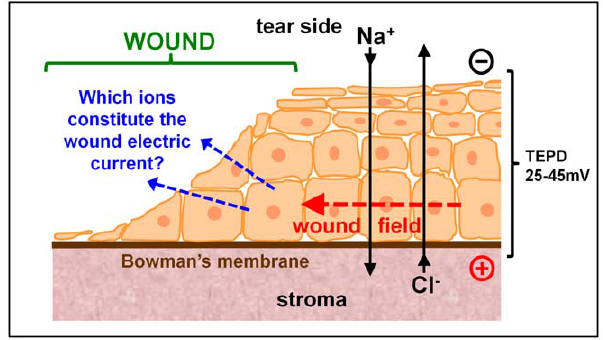
Figure 1. Which ions contribute to the wound electric current? The corneal epithelium transports ions to generate and maintain a transepithelial potential difference (TEPD) of , 25–45 mV. Injury breaks the epithelial barrier and collapses the potential at the wound (left). The positive potential in the surrounding intact epithlium drives ion current flow out of the wound (blue arrows) and forms laterally-orientated wound electric fields (red arrow) with the wound the cathode.